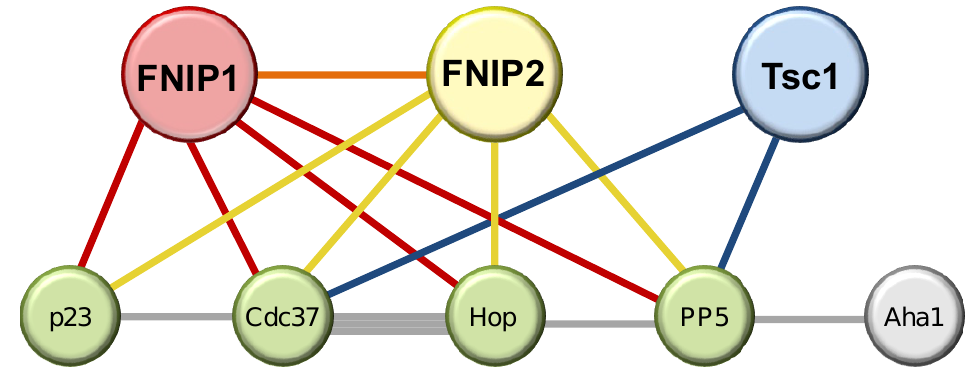
Figure 3. FNIPs and Tsc1 co-chaperone interaction network. Hsp90 co-chaperones are represented by colored circles. Interactions between co-chaperones are denoted by colored lines. FNIP1 interac- tions are colored red; FNIP2, yellow; Tsc1, blue; other,